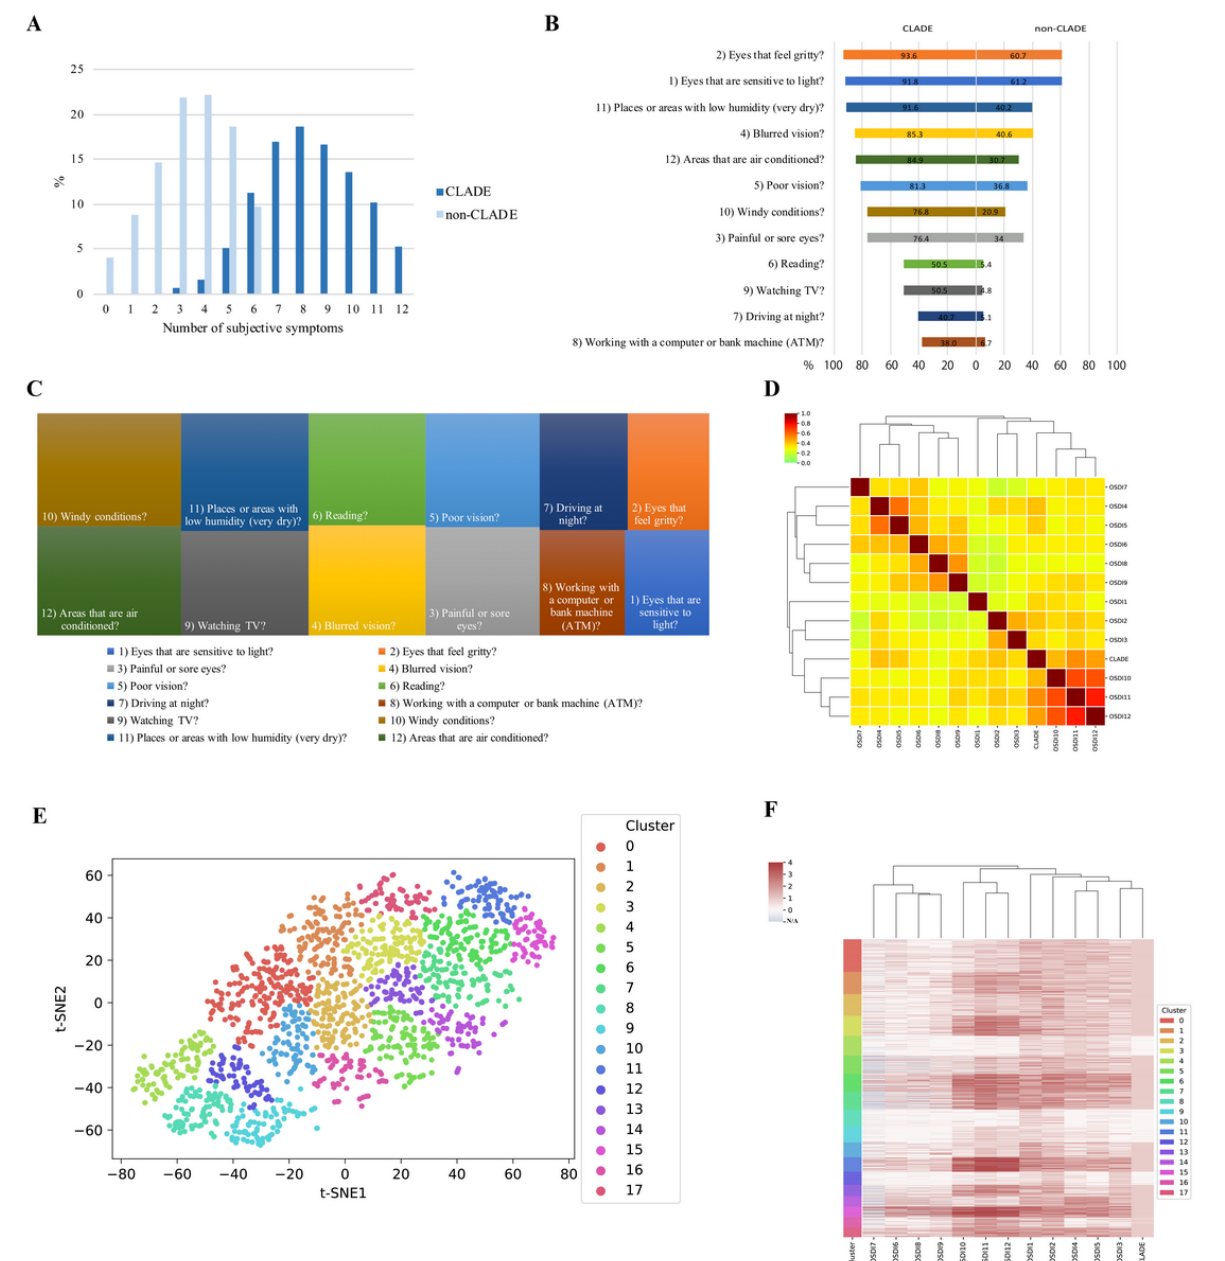
Figure 3. Stratification of subjective symptoms of CLADE. (A) The number of subjective symptoms in the non-CLADE and CLADE groups. (B) The frequency of subjective symptoms of DED based on each OSDI questionnaire. (C) The treemap shows the difference in the frequency of subjective symptoms of DED (the percentage of subjective symptoms in the CLADE group minus the percentage of subjective symptoms in the non-CLADE group) based on each OSDI question. (D) The Pearson correlation coefficients between subjective symptoms and CLADE are shown in the heatmap as a color gradient. (E) t-SNE projection shows the groups of CLADE based on the subjective symptoms. (F) The heatmap shows the correlation between the groups made by t-SNE projection and each OSDI item. CLADE: contact lens–associated dry eye. DED: dry eye disease. OSDI: Ocular Surface Disease Index. t-SNE: t-distributed Stochastic Neighbor